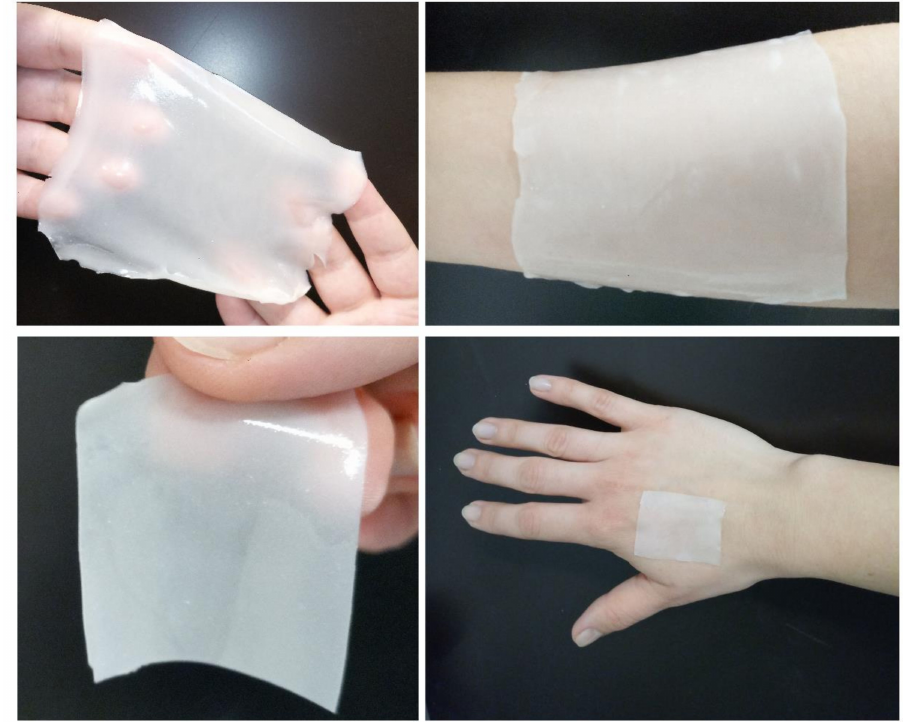
Figure 5. Examples of di ff erent sizes and shapes on which it can be applied the patch loaded with